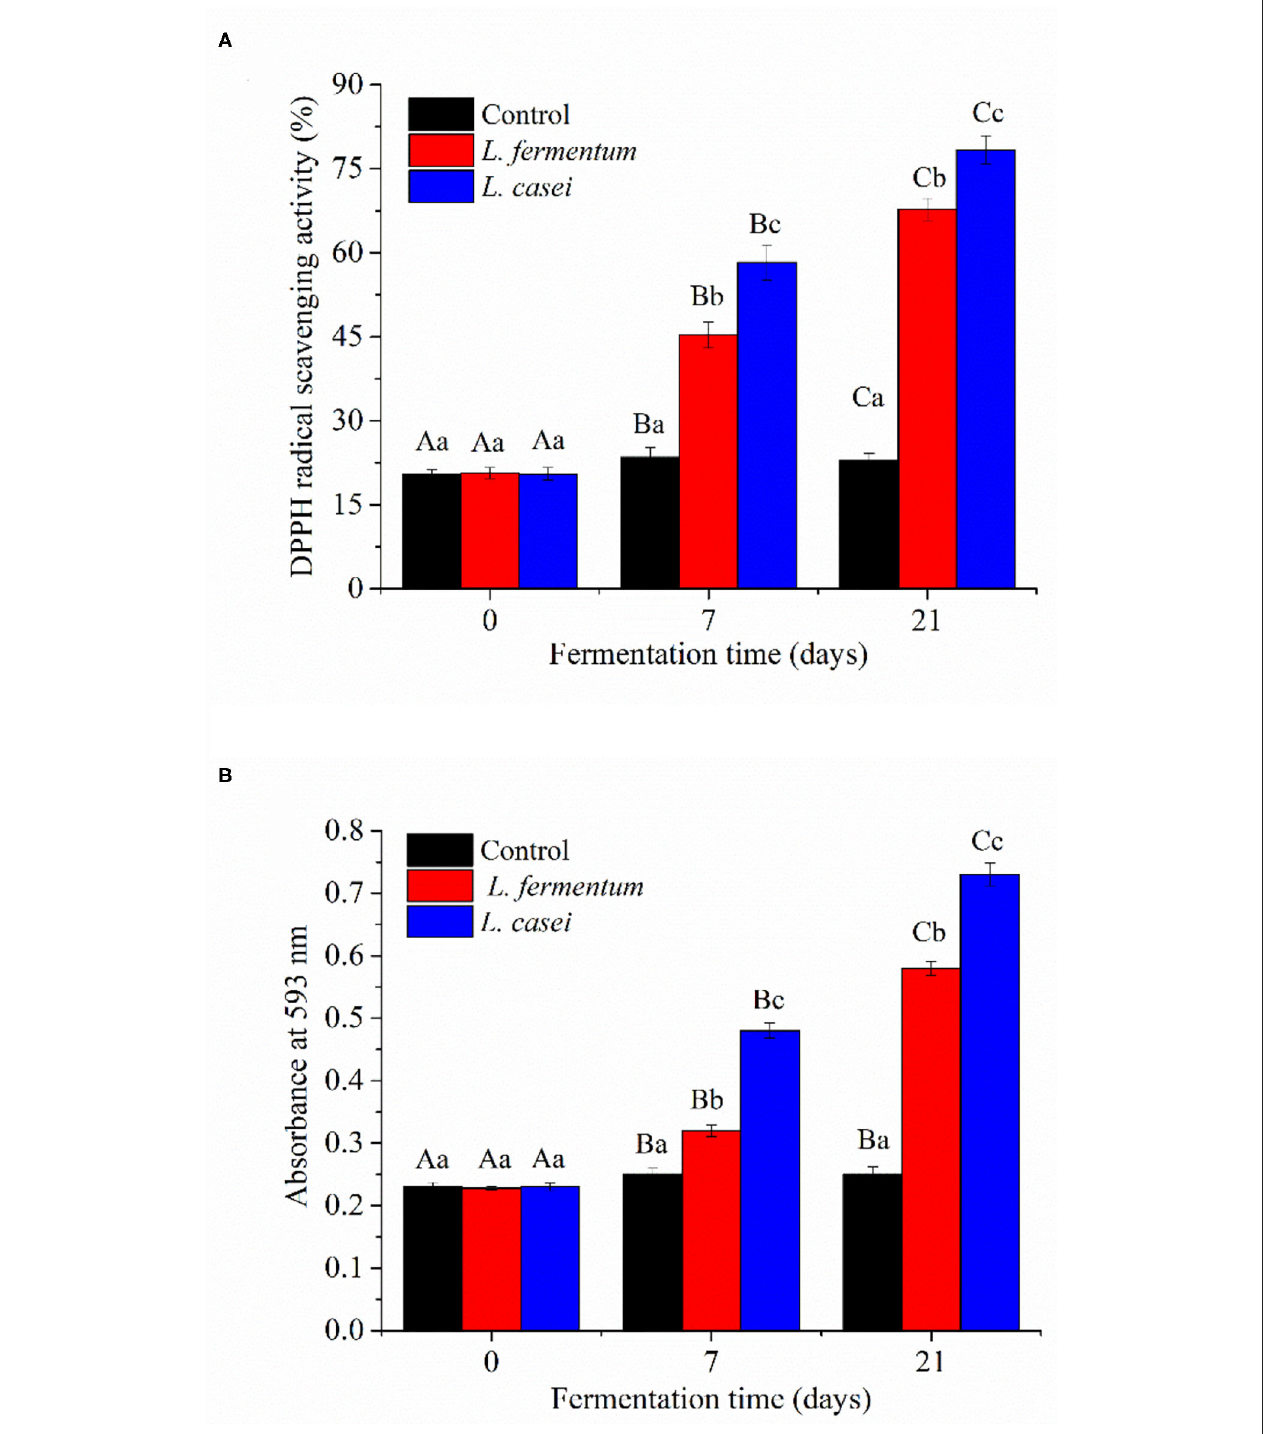
FIGURE 4 | DPPH radical scavenging activity (A) and FRAP (B) of P. yezoensis sauces during fermentation. Values with different letters within each samples indicated a significant difference in content ( p < 0.05). casei fermentation reduced the concentration of acetic acid, consequently atteunating the pungent smell of P. yezoensis sauces (36). At the same time, the release of acetic acid indicates that L. casei has the ability to metabolize lactic acid